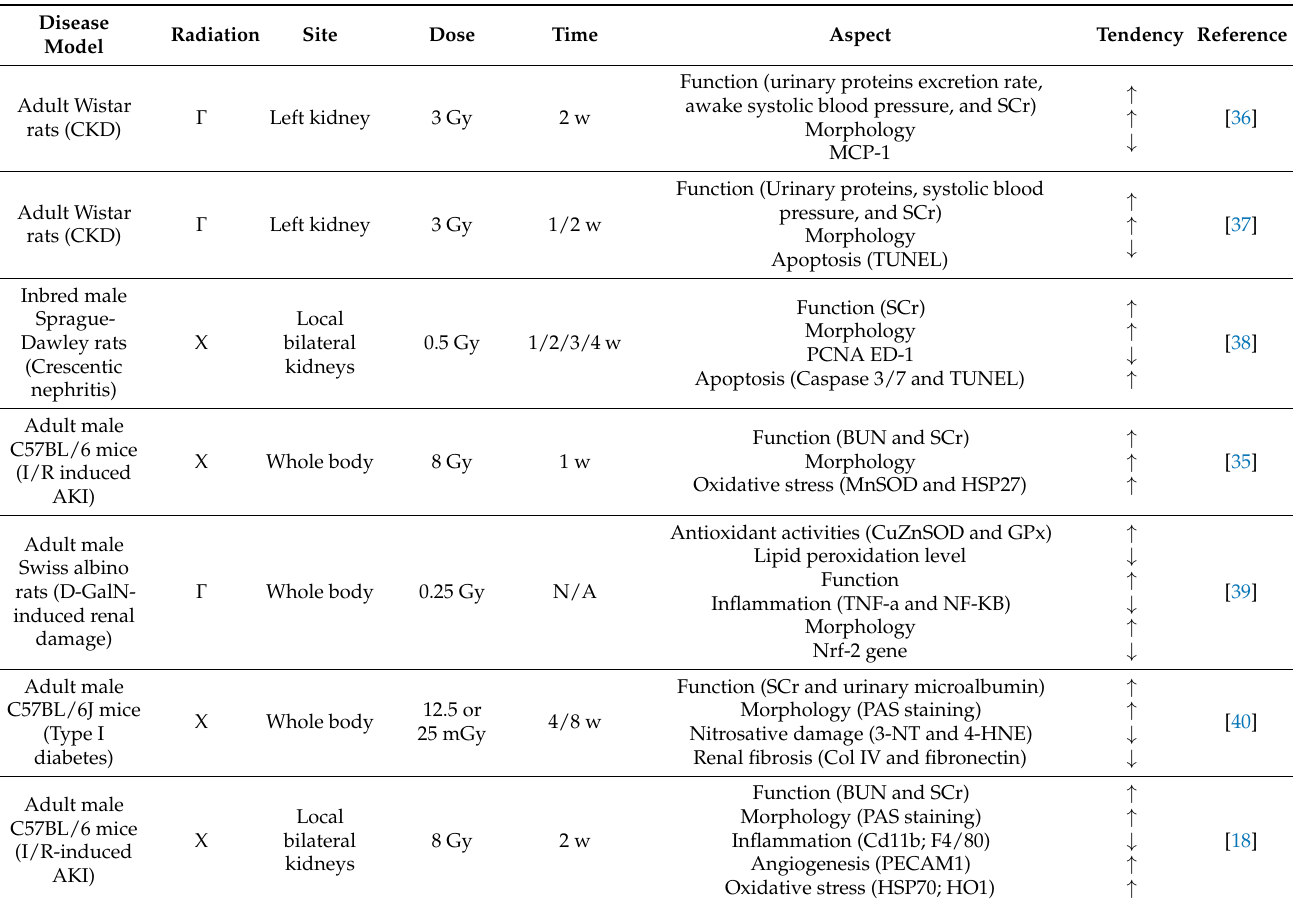
Table 2. Summary of the literature exhibiting renal protection following ionizing irradiation on dif- ferent assays at different doses in rodent experimental disease models: monocyte chemoattractant protein-1(MCP-1), dUTP nick-end labeling (TUNEL), nuclear factor erythroid 2-related factor 2 (Nrf-2), urinary microalbumin (Malb), blood urea nitrogen (BUN), serum creatinine (SCr), 3-nitrotyrosine (3-NT), 4-hydroxynonenal (4-HNE), superoxide dismutase (CuZnSOD), manganese superoxide dismutase (Mn- SOD), glutathione peroxidase GPx, heme oxygenase 1 (HO1), heat shock protein (HSP), platelet and endothelial cell adhesion molecule 1 (PECAM1), collagen IV (Col IV), ↑ : significant functional and morphological improvement, and ↓ : significant decrease in degradation markers. Aspect Tendency